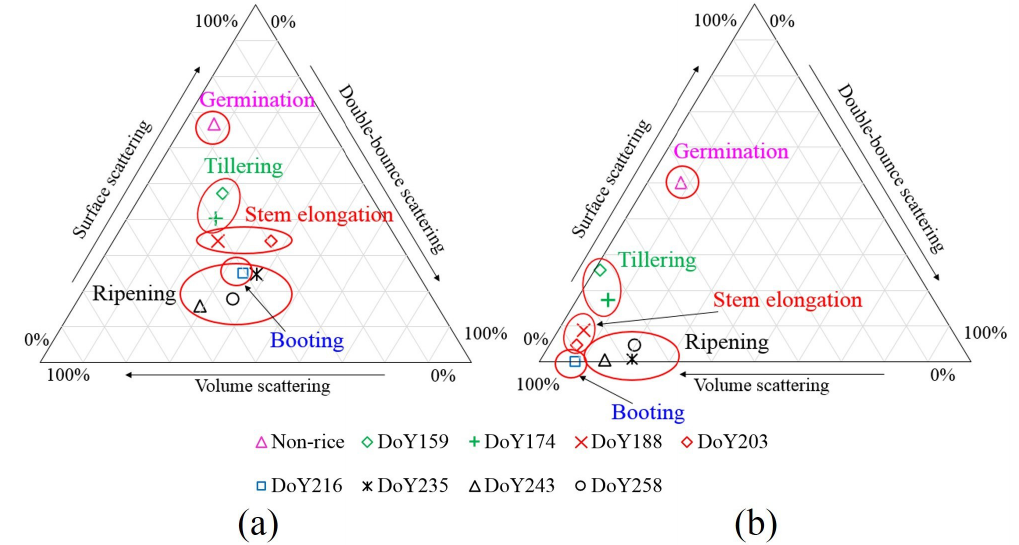
Figure 12. Relative contribution of surface, double-bounce, and volume scattering components on the triangle plot. ( a ) FCP mode; ( b ) DCP